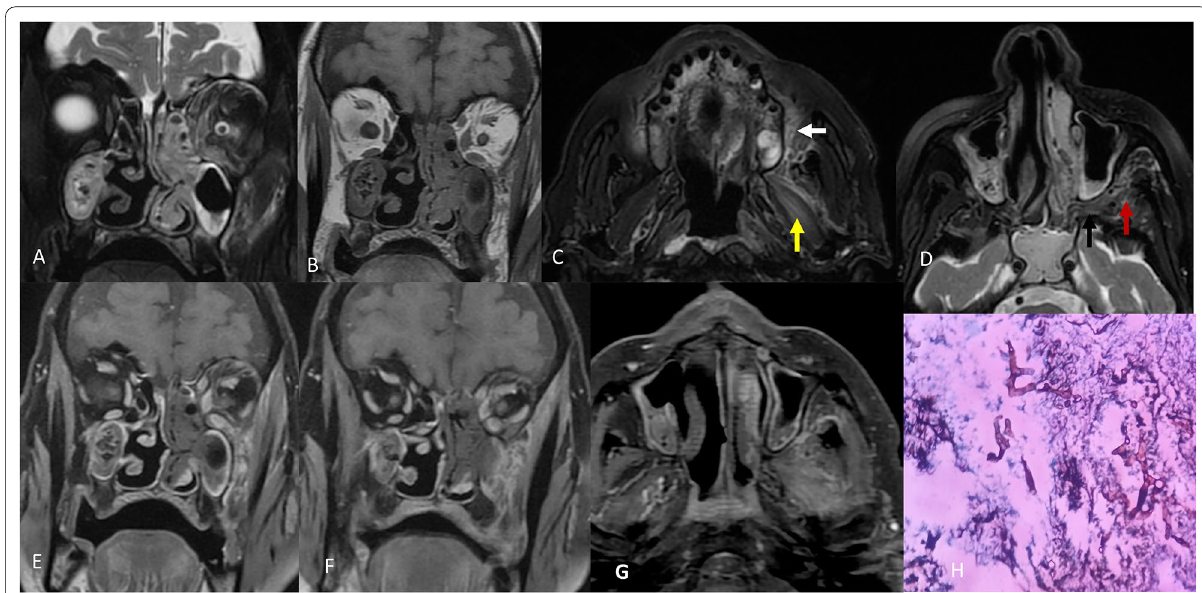
Fig. 8 T2 fat suppressed coronal ( A ) and T1W coronal ( B ) images show evidence of extensive hypertrophy of turbinates on left side with opacification of bilateral maxillary and left ethmoidal sinuses with heterogeneous T2 hyperintense contents showing foci of signal void consistent with fungal elements. There is involvement of left orbit in contiguity with left ethmoid sinus in the form of bulky superior oblique, medial and inferior recti muscles with orbital fat stranding. Preseptal swelling and proptosis of left orbit were also present (not shown here). C , D T2W fat suppressed axial images showing complete opacification of sphenoid sinus in addition to above-mentioned findings along with hyperintensity in peri-alveolar (white arrow), pterygoid muscle (yellow arrow), pterygopalatine fossa (black arrow) and infratemporal fossa (red arrow) with corresponding enhancement on post contrast images ( E – G T1 post contrast images). Post contrast images also show black turbinate sign. H: Microphotograph from debrided material showing black coloured aseptate fungal hyphae seen in the necrotic slough likely to be mucormycosis (GMS stain